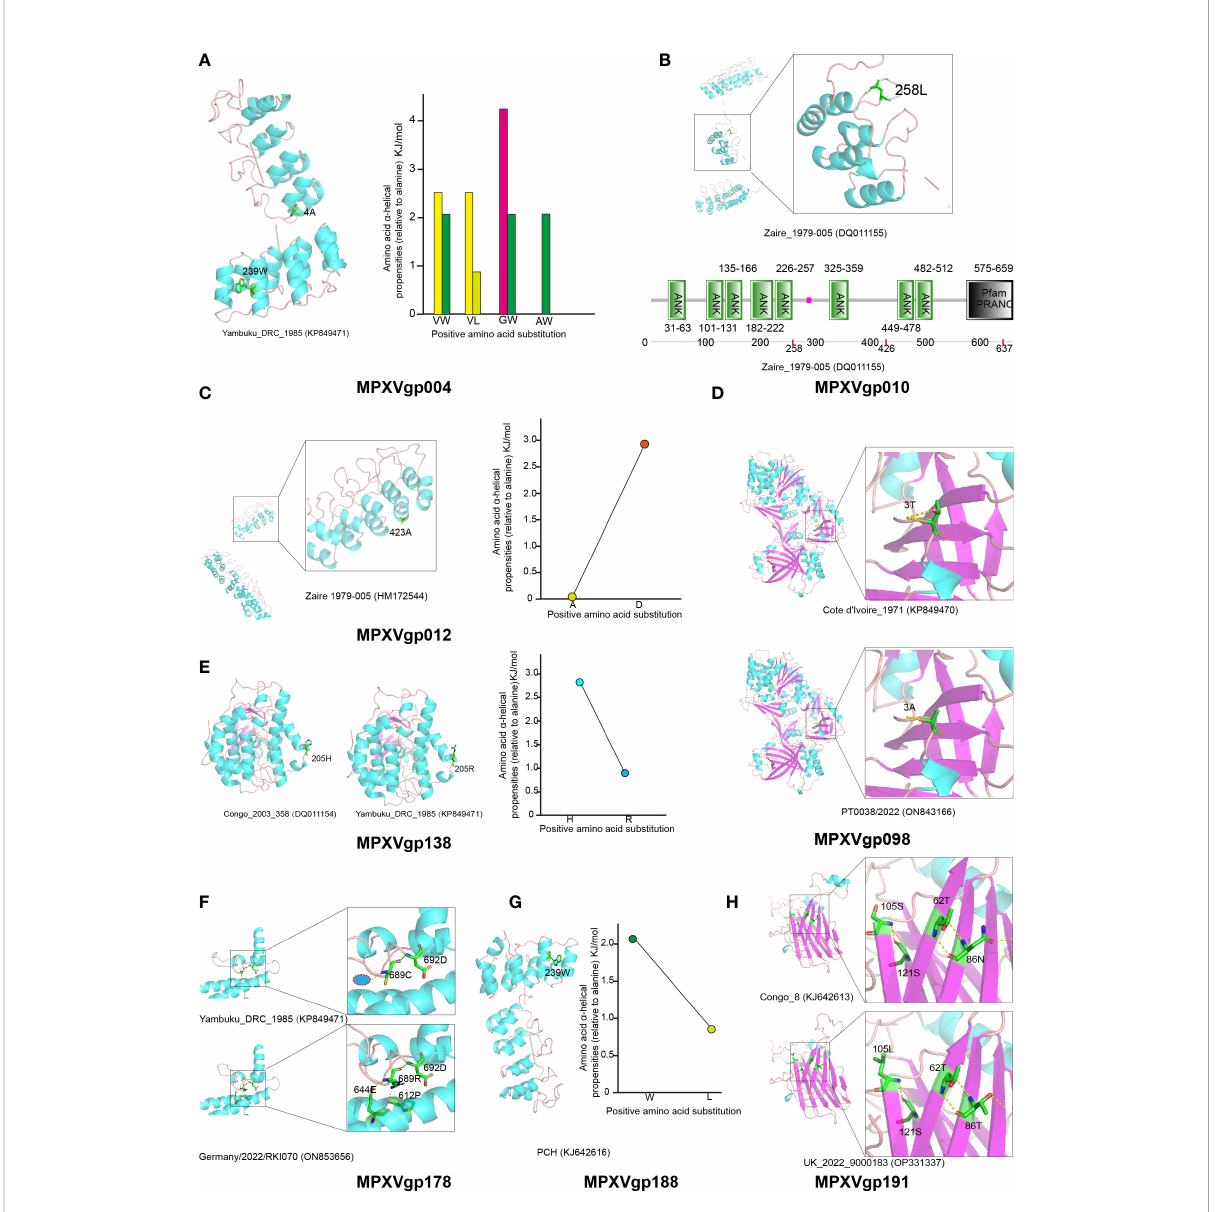
FIGURE 7 Structure of MPXV proteins that are under positive selection and potential in fl uence of amino acid substitutions in positive selection sites. Secondary structure elements of proteins encoded by positively selected genes are colored in cyan (helix), purple (sheet), and orange (loop), respectively. The amino acid residues that undergo positive selection are shown as sticks. (A) Left: The protein structure of MPXVgp004 is shown using strain Yambuku_DRC_1985 as a reference. Right: Amino acid a -helical propensities among different substitution pro fi les are shown. (B) Up: The protein structure of MPXVgp010 is shown using strain Zaire_1979-005 as a reference. Down: Annotation of protein domains and the domain architectures of MPXVgp010. Predictive domains and amino acid residue ranges of each domain are shown. The red dots indicate the location of positive selection sites. (C) Left: The protein structure of MPXVgp012 (part) is shown with strain Zaire 1979-005 as a reference. Right: Amino acid a -helical propensities of substitution A423D. (D) Up: The protein structure of MPXVgp098 is shown with strain Cote d ’ Ivoire_1971 as a reference and amino acid residue 3T is shown as a stick. Down: The protein structure of MPXVgp098 is shown using strain PT0033/2022 as a reference and amino acid residue 3A is shown as a stick. Yellow dotted lines indicate H-bonds. The T3A substitution leads to a decrease of H-bond, which may interact with the small subunit of mRNA capping enzyme. (E) Left: Protein structures of MPXVgp138 with different amino acid residues at the positive selection sites. Right: Amino acid a -helical propensities among different substitution pro fi les are shown. (F) Comparing MPXVgp178 protein structures with different amino acid residues (689C and 689R) at positive selection sites. The Phyre server could not model MPXVgp178 allele with 689H; thus, it was not shown. Amino acid residues of those that interact with residue 689 are shown as sticks. H-bonds are shown as yellow dotted lines. A red circle wrapped in blue indicates a putative water molecule. (G) Left: The protein structure of MPXVgp188 is shown using strain PCH as a reference and amino acid residue 239W is shown as a stick. Right: Amino acid a -helical propensities of substitution (W239L) are shown. (H) Comparing MPXVgp191 protein structures with different amino acid residues (86N, 105S and 86T, 105L) at positive selection sites. Amino acid residues of those that interact with residues 86 and 105 are shown as sticks. H-bonds are shown as yellow dotted